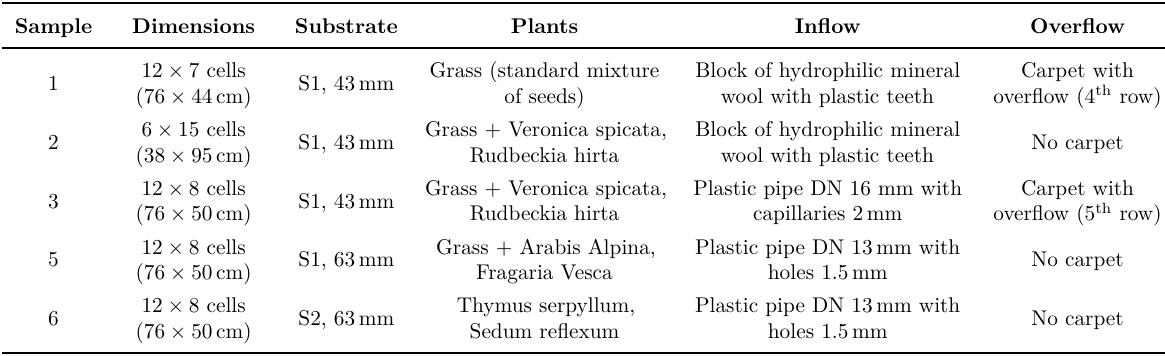
Table 1. Definition of test